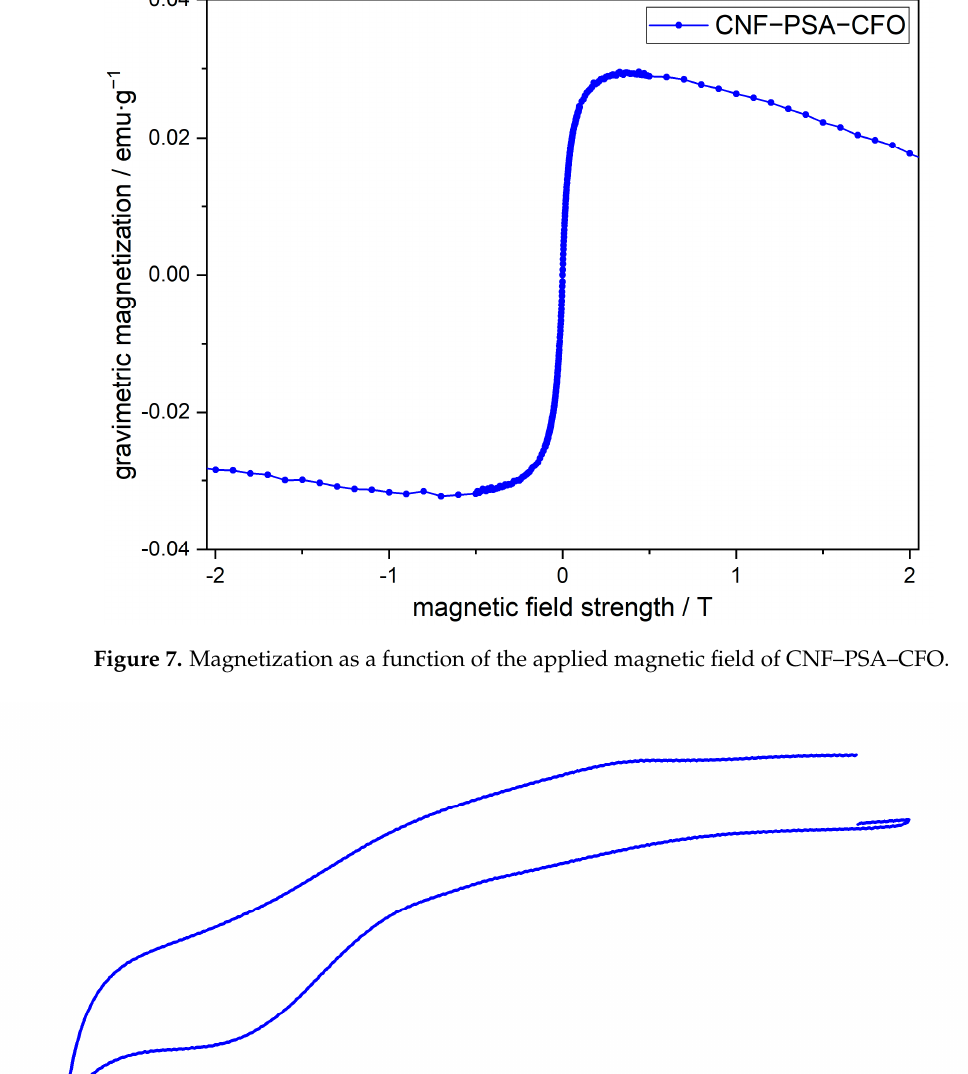
Fibers 2023 , 11 , 2